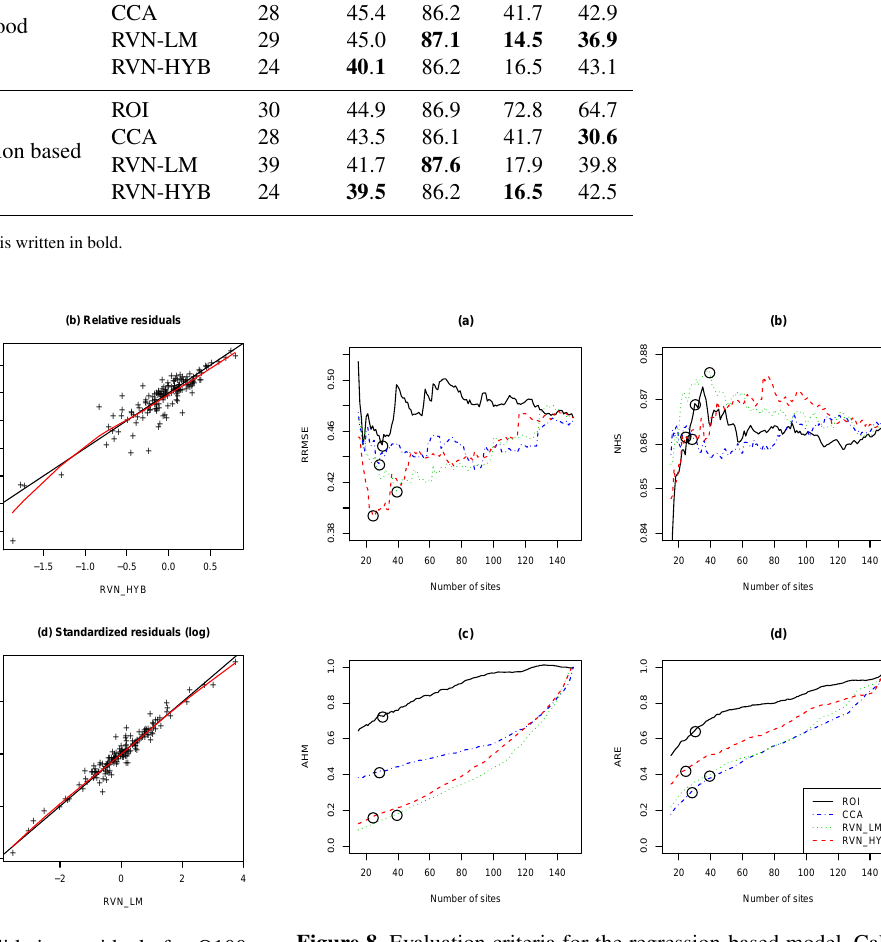
Figure 7. Comparison of the cross-validation residuals for Q100 for different methods. The black line is the unitary slope and the red line is a smooth fitting of the residuals.